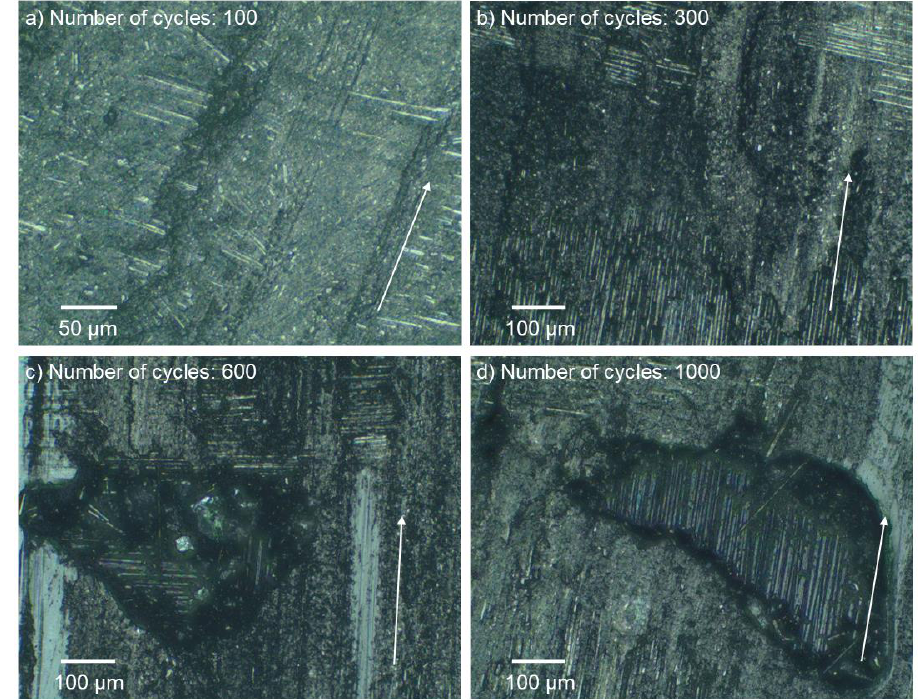
Figure 5. Changes on the composite surface that did not undergo weathering after: ( a ) 100, ( b ) 300, ( c ) 600, and ( d ) 1000 cycles of dry abrasive wear (arrows show the direction of the reciprocating sliding).